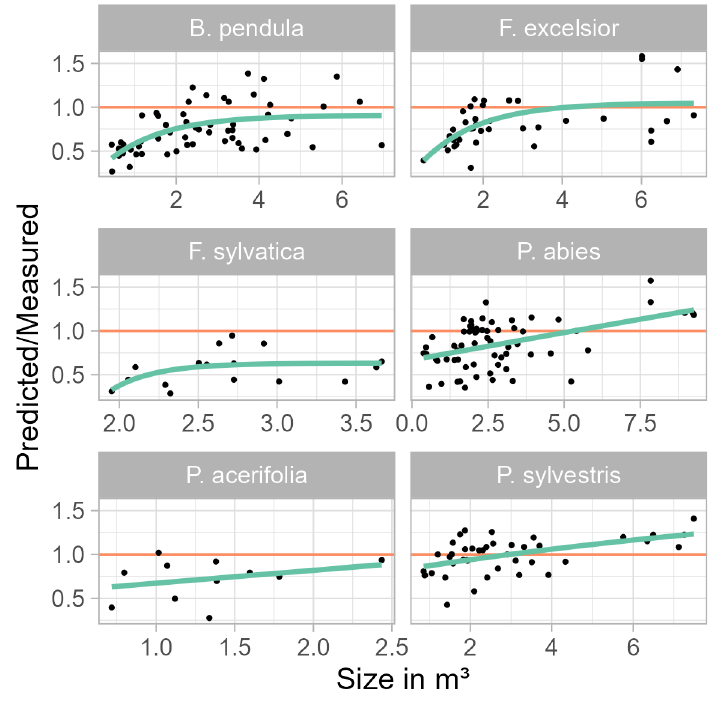
Figure 4. Depending on the degree of non-linearity in the relationship between rotational stiffness and anchorage strength, the ratio between predicted (Equation (1)) and measured anchorage strength approaches 1 (red line) for larger trees. Fitted lines: 2.5 k r